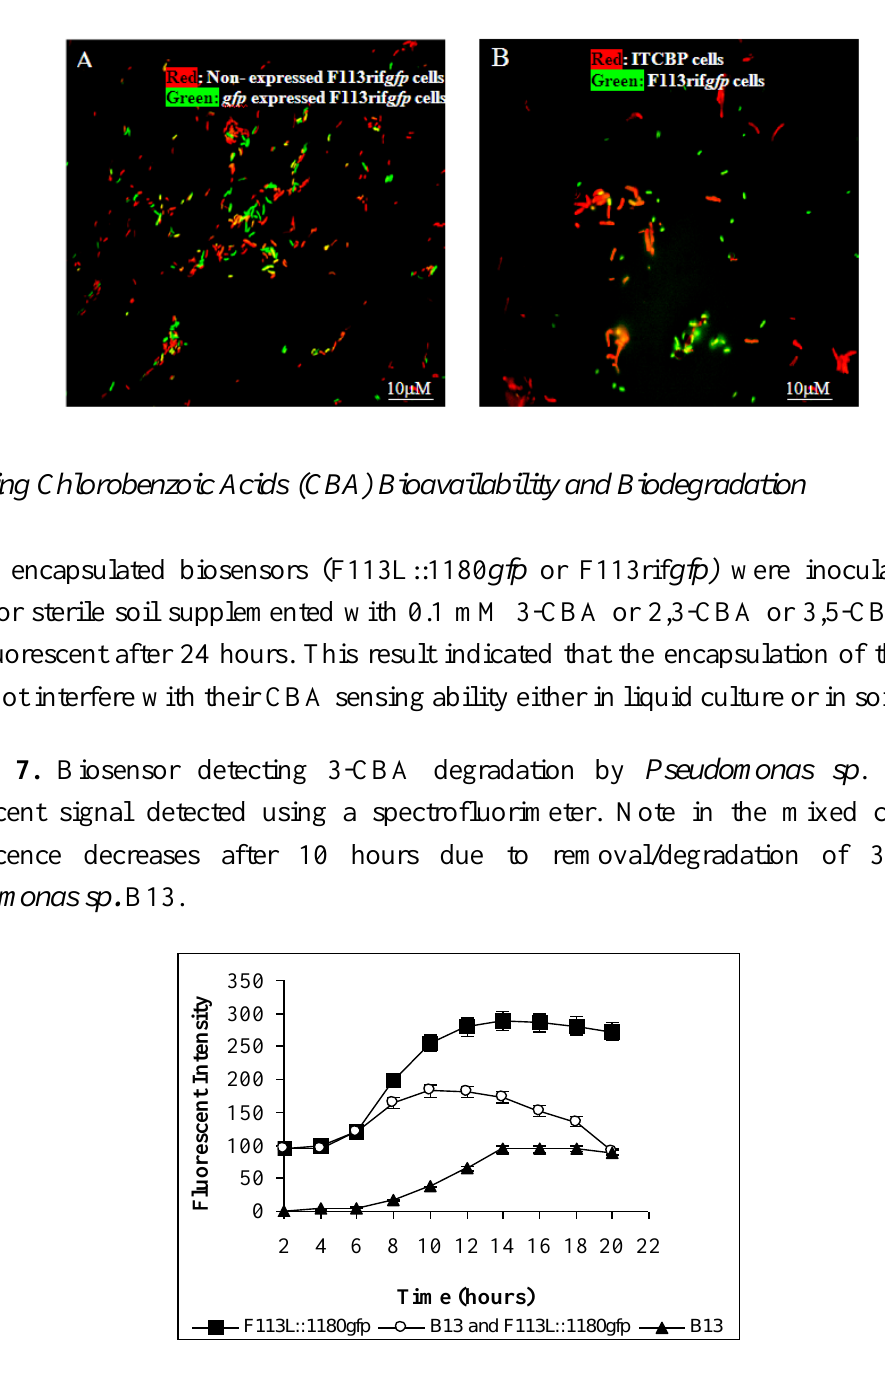
Figure 6. Epifluorescent micrographs showing encapsulated biosensor F113rif gfp detecting 3-CBP degradation by Rhodococcus sp. ITCBP. (A) Biosensor F113rif gfp cells in liquid culture; (B) Rhodococcus sp. ITCBP cells and biosensor F113rif gfp cells in the soil.